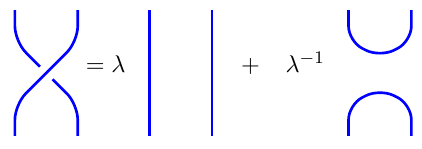
Figure 15 . Jones representation of the braid group in pictures. Here A = λ